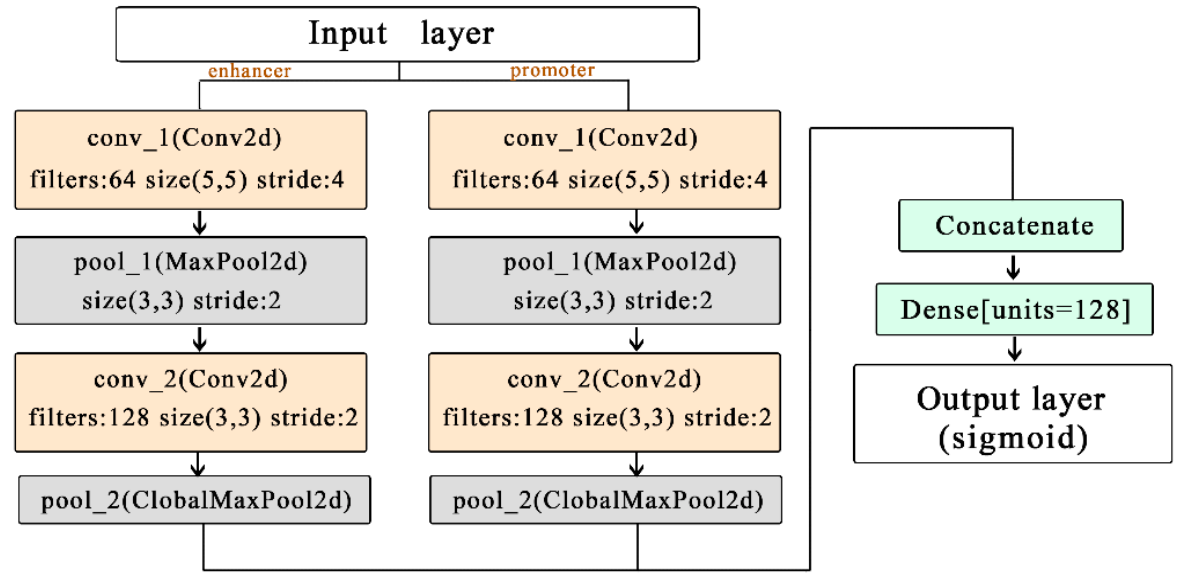
Figure 2. Hilbert curve encoding.